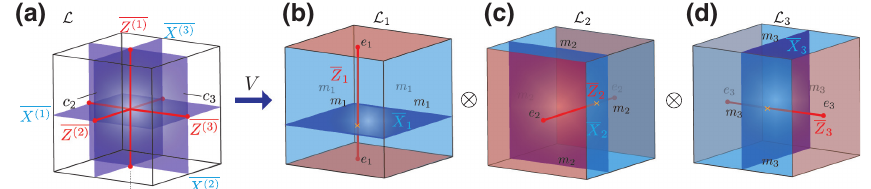
FIG. 41. Disentangling a single 3D color code into three copies of 3D surface codes aligned in perpendicular directions. The correspondence of the logical operators in the color code and the three surface codes is